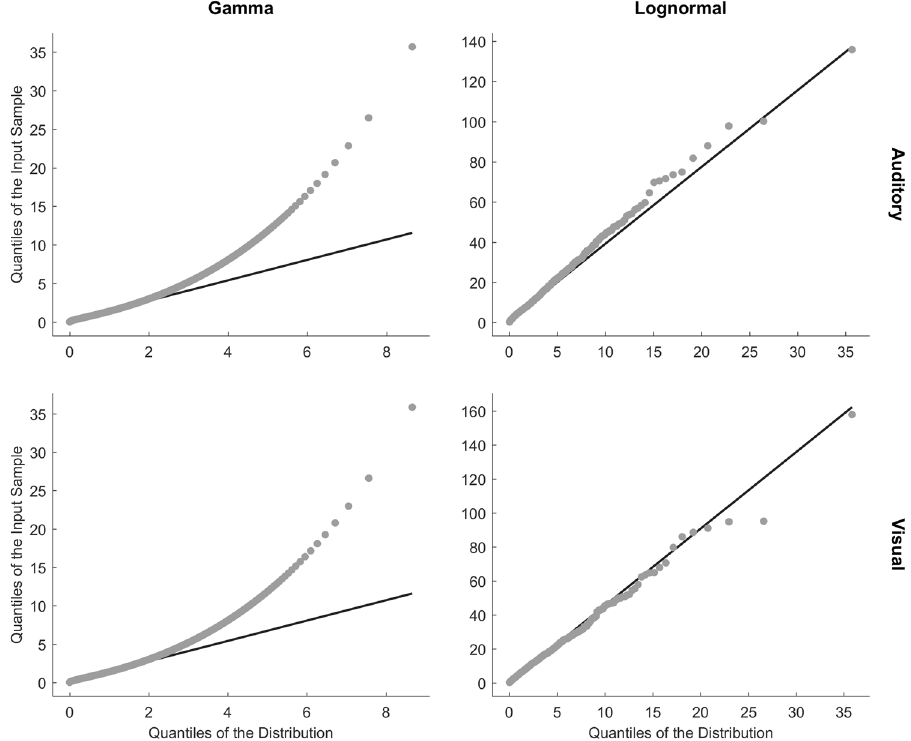
Figure 3. QQ-plots of gamma (left) and log-normal (right) distributions for phase durations from the Neutral conditions in the auditory (upper row) and visual (lower row)